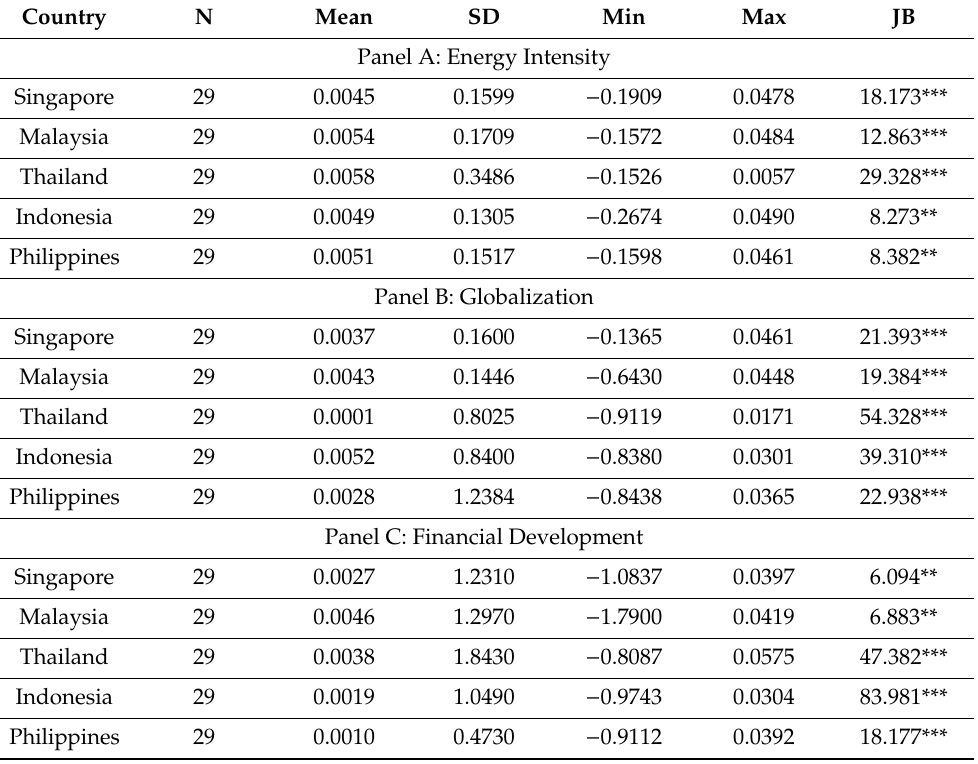
Table 1. Results of Descriptive